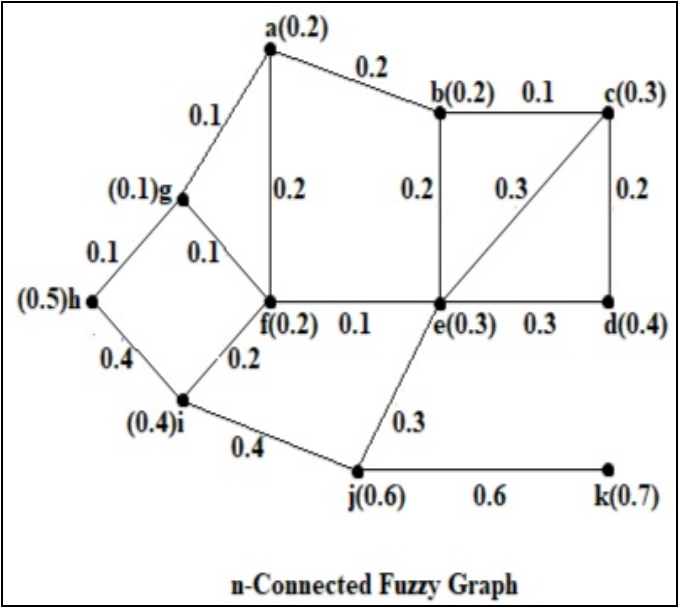
Figure 2. An 11-connected fuzzy graph.